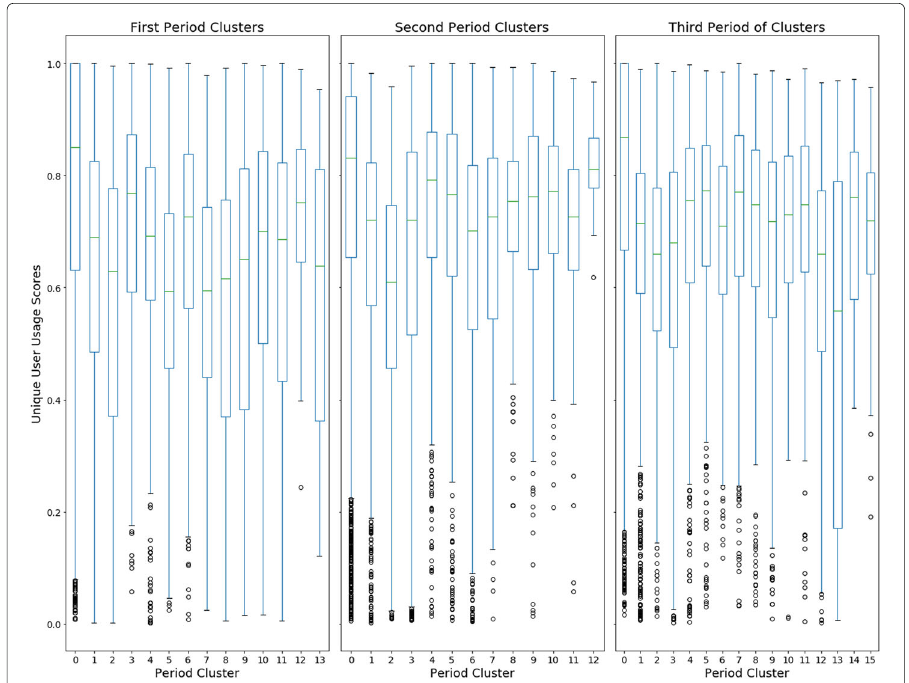
Fig. 10 Box and whisker plot of the unique user scores for each of the hashtags within a cluster. Generally, each cluster has a relatively wide spread of scores which indicates hashtags that have many unique users and those with very few being present in each cluster. Many clusters also contain low-scoring outliers which are hashtags that are used by very few or even just one